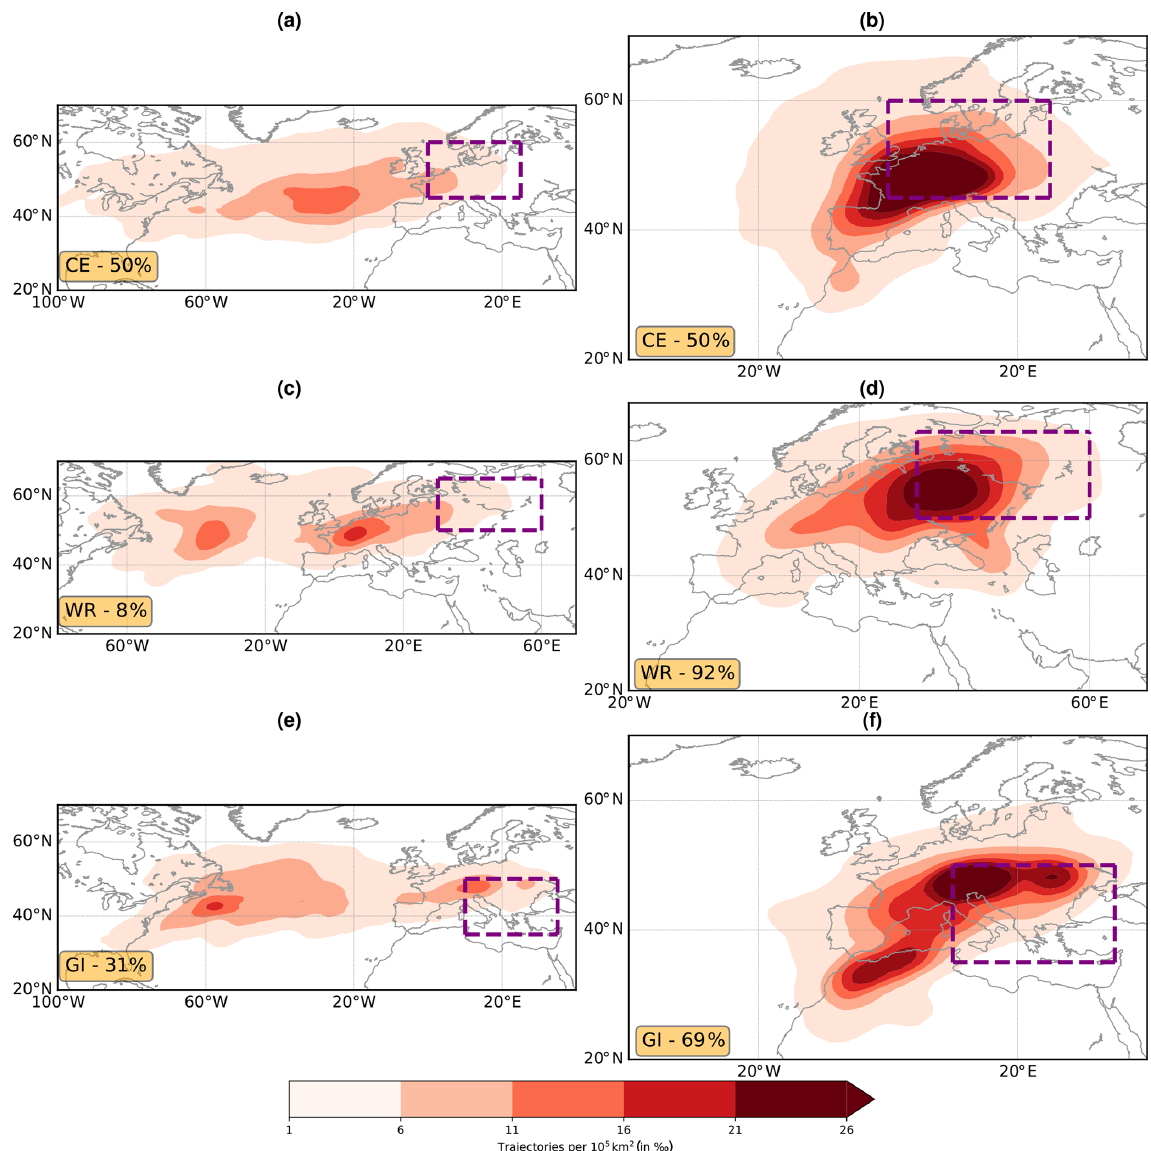
Figure 6. Geographic location of the maximum diabatic heating along trajectories for the remote (a, c, e) and nearby heating branch (b, d, f) during the last 3d prior to reaching upper-tropospheric anticyclones above central Europe (CE), western Russia (WR) and Greece–Italy (GI). The percentages in the orange boxes denote the fraction of the remote and nearby heating branch with respect to the whole heating